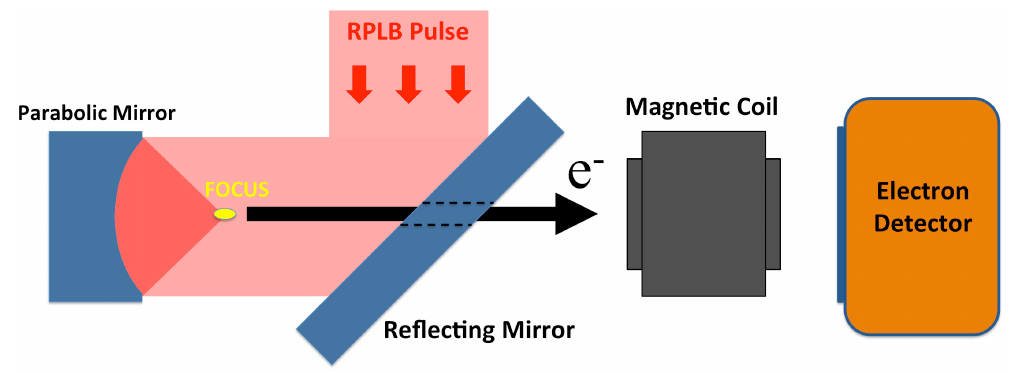
Figure 8. RPLP electron acceleration and measurement set-up. The 25-mm diameter RPLP is reflected off a mirror placed at 45 ◦ and sent toward the focusing on-axis parabola. The resulting longitudinal field at focus is strong enough to ionize the oxygen molecules from the ambient gas (800 mTorr) and accelerate the photo-electrons along the propagation axis. The electron beam created passes through a small aperture (4 mm) in the reflecting mirror and is collected by different detectors positioned 10 cm away from the focal plane